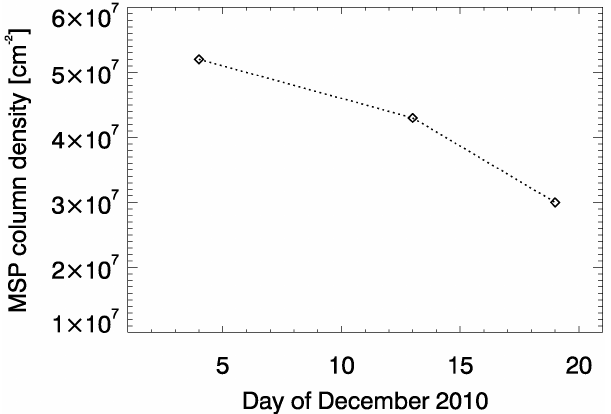
Fig. 9. Column density of meteoric smoke particles (MSP) mea- sured in-situ during the launches of ECOMA 7 to 9.